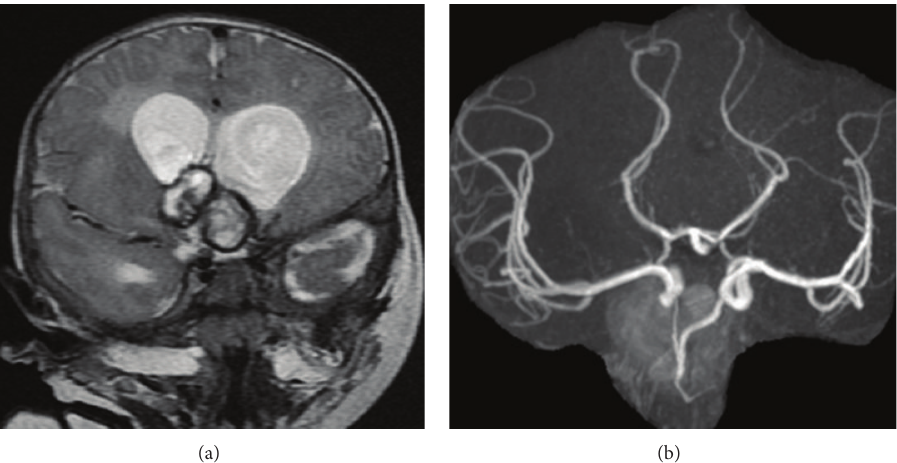
Figure 4: MRA performed 2 weeks after onset of hemorrhagic event. (a) No active hydrocephalus and volume reduction of the thrombosed aneurysm; (b) right ACA